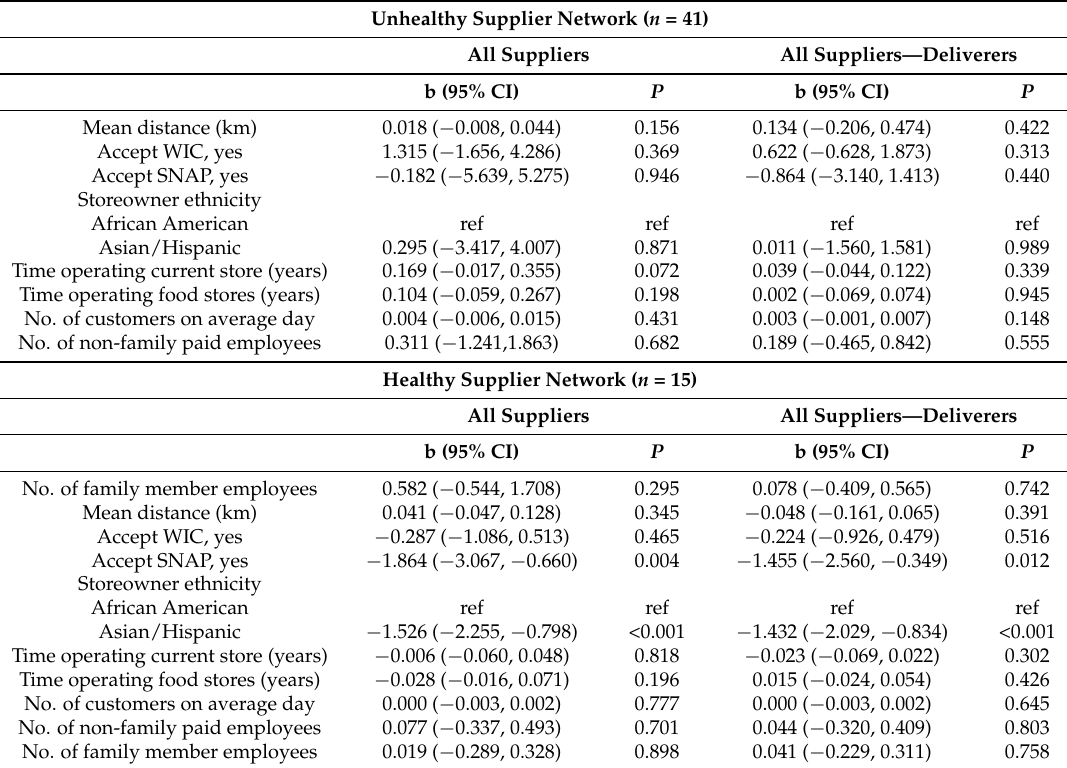
Table A2. Bivariate analyses of corner stores’ supplier networks, outcome variable being degree centrality; excludes delivering